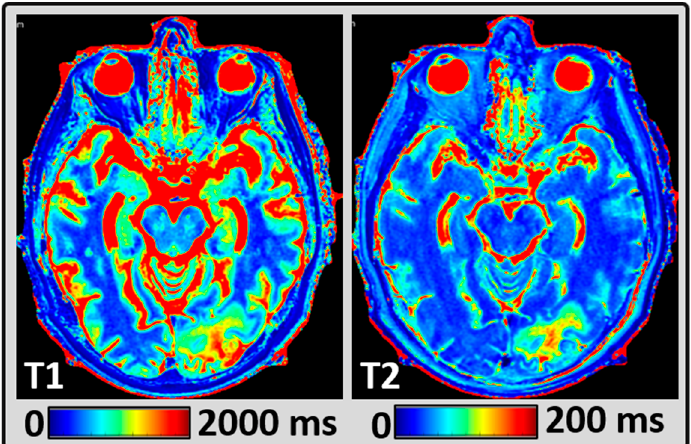
Figure 3. Representative MRI data from the same patient as Figure 2, showing quantitative images. (A and B) synthetically-generated T1 and T2 maps, respectively, from MAGiC. The box plot in Figure 4 exhibits T1 and T2 values obtained from normal-appearing GM, WM, and CSF regions using MAGiC-generated T1 and T2 maps. GM mean values for T1 and T2 were 1143 ms and 78 ms, respectively. Mean T1 and T2 values for WM were 701 ms and 64 ms, respectively. Mean T1 and T2 values for CSF regions were 4206 ms and 390 ms,